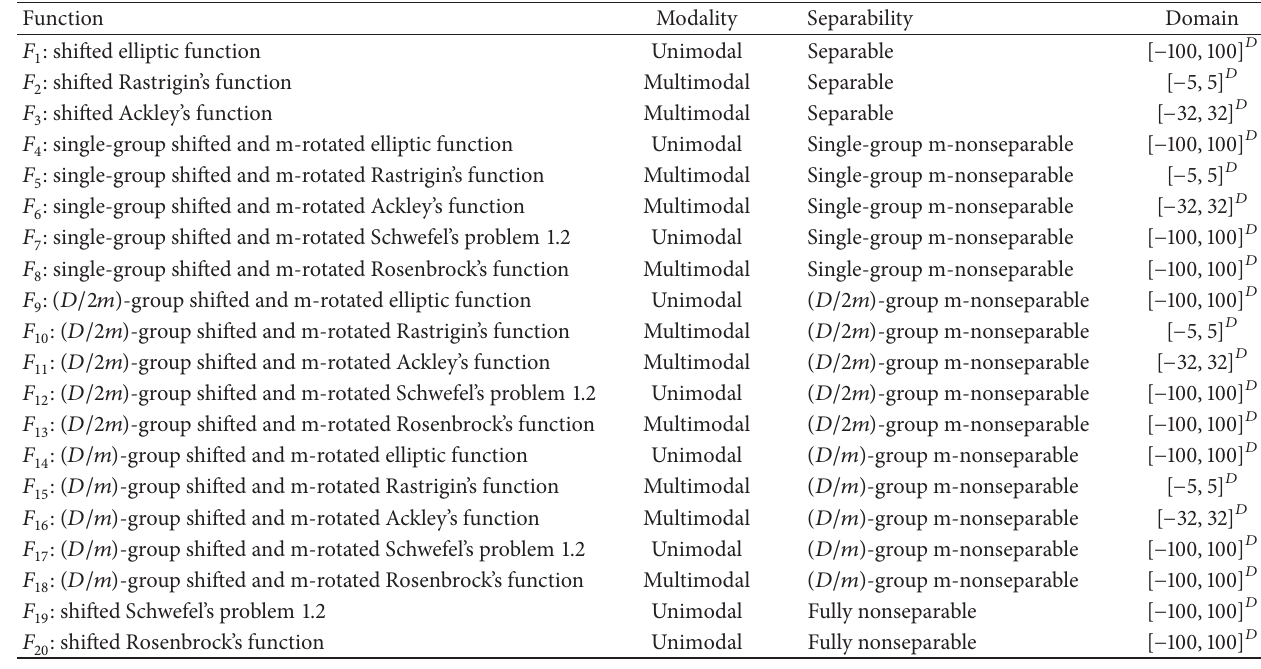
Table 1: Properties of the benchmark functions CEC’2010 [16].